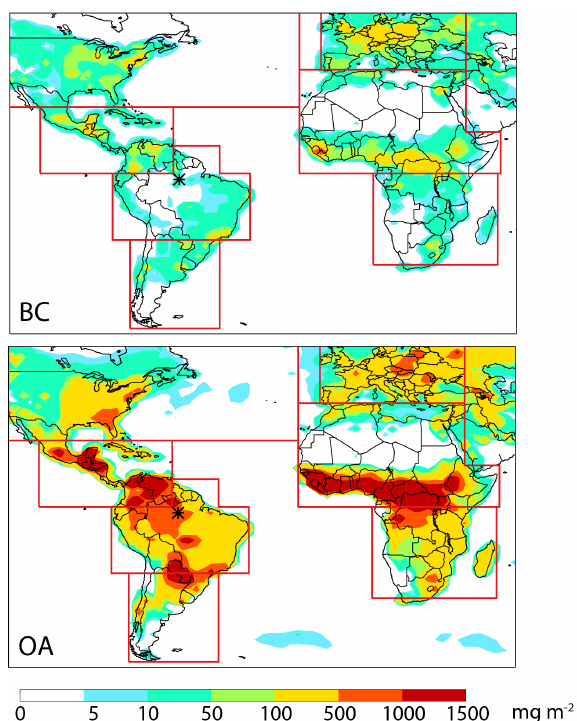
Figure 1. GEOS-Chem emissions of black carbon (BC) and organic aerosol (OA) during January–April 2014 over 120 ◦ W–60 ◦ E and 60 ◦ S–60 ◦ N. Red lines show the limits of the seven selected regions as defined in Table 2. The black asterisk is the location of ATTO.